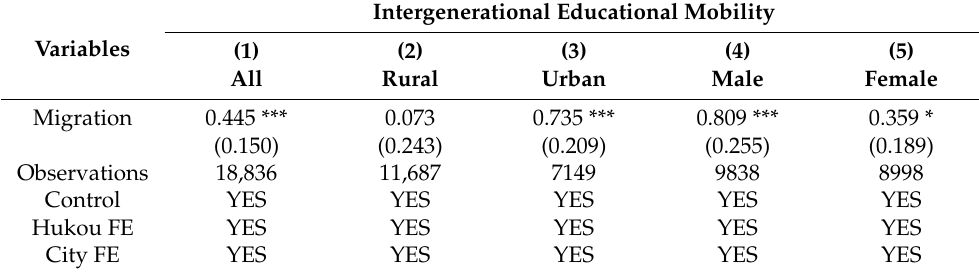
Table 4. Urban-rural differences and gender